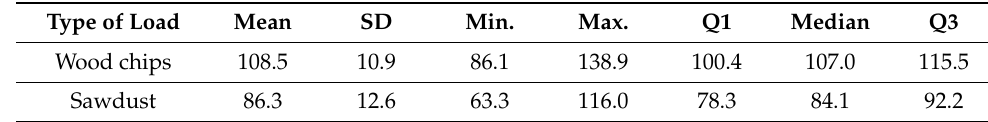
Table 3. Statistical characteristics of absolute moisture content of the